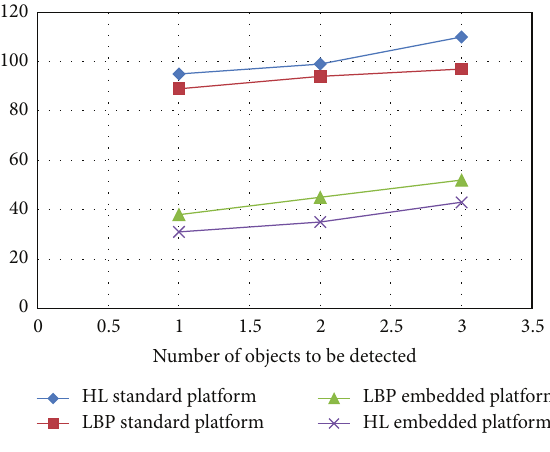
Figure 10: Performance on different